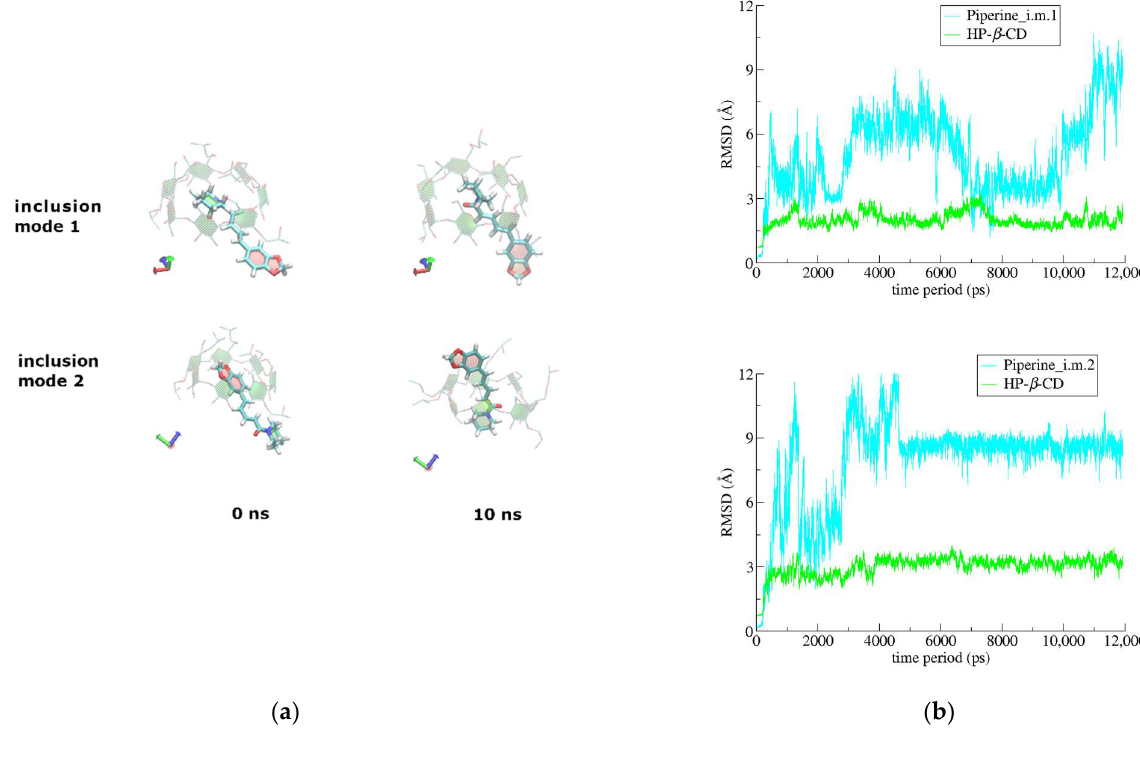
Figure 8. ( a ) Representative snapshots for the two different starting poses of PN/HP- β -CD inclusion complex at 0 and 10 ns during simulation time. ( b ) RMSD to the first frame for the inclusion complexes of PN_i.m.1/HP- β -CD and PN_i.m.2/HP- β -CD as a function of MD simulations time. Table 3. Binding free energies and their standard deviations (kcal/mole) resulting from MM/GBSA analysis of the inclusion compounds of PN in β - CD, DM- β - CD, TM- β - CD and HP- β - CD